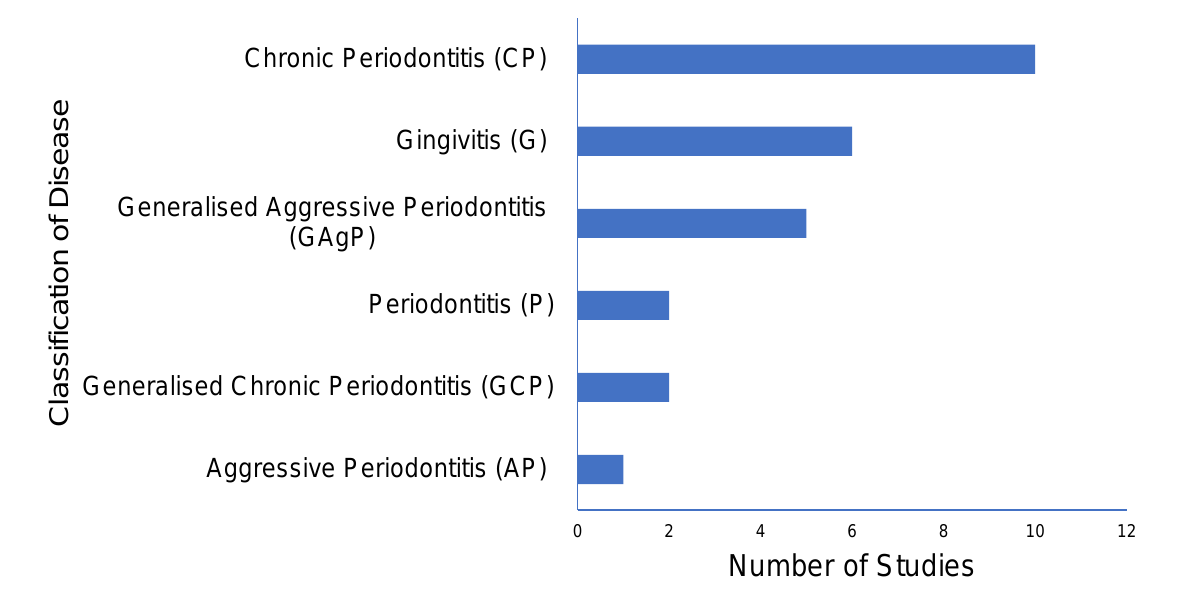
Figure 3. Horizontal bar chart outlining the breakdown of disease classification among the 15 stud- ies.